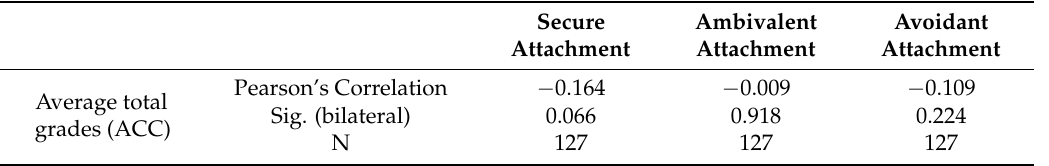
Table 7. Correlation between the subscales of the quality of childhood-attachment with the average of the total grades, in